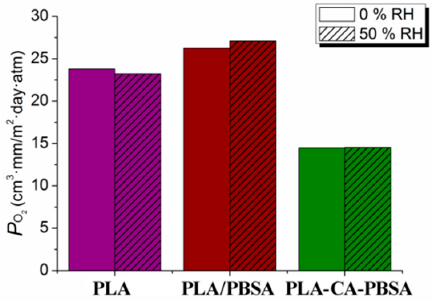
Figure 7. Oxygen permeability of PLA, PLA/PBSA and PLA-CA-PBSA